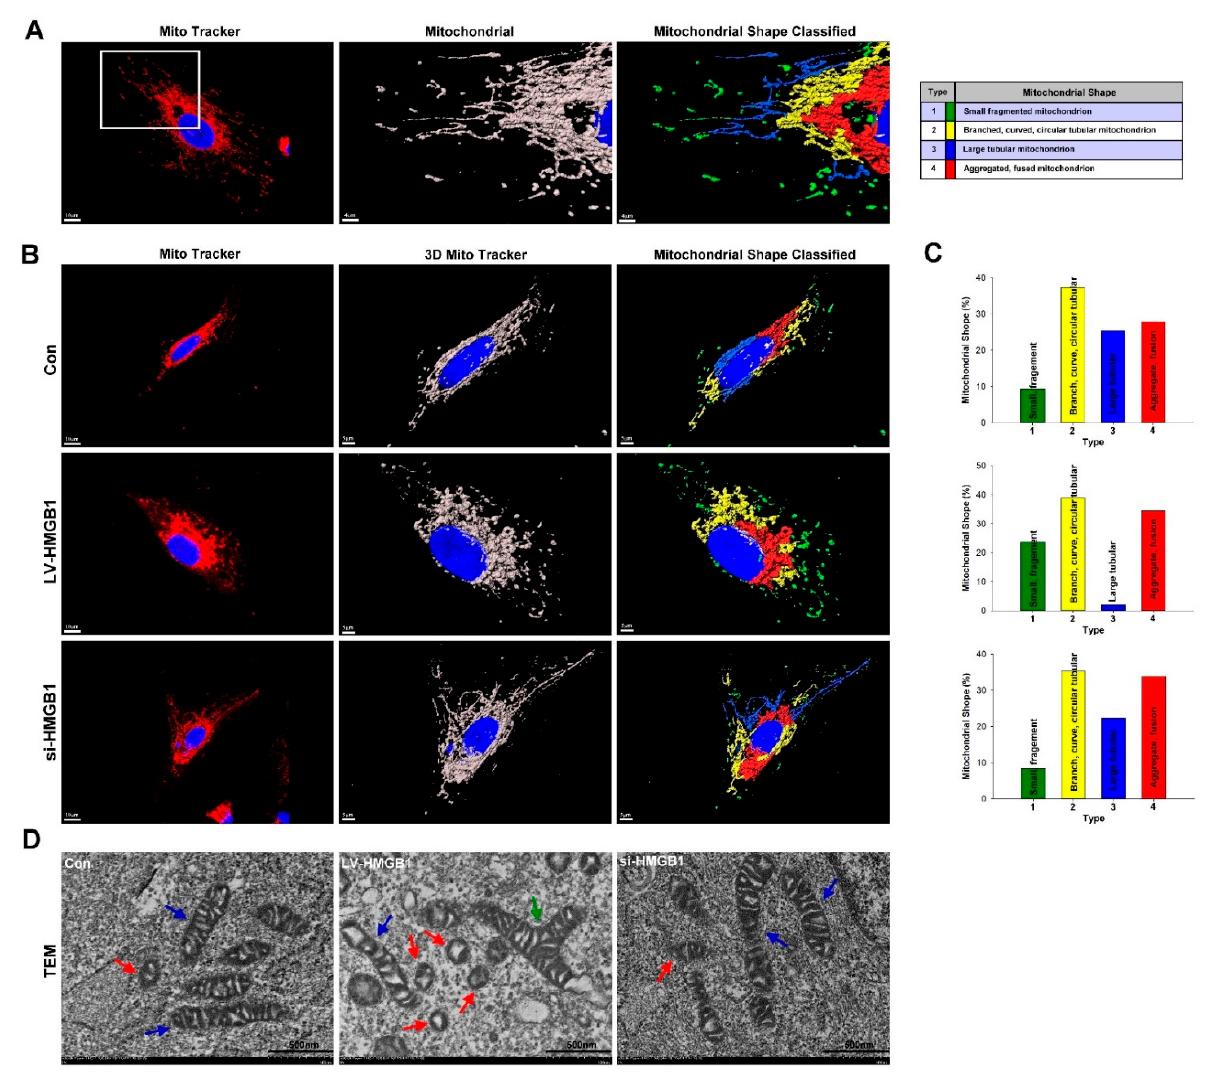
Figure 2. Mitochondrial dynamics is regulated by HMGB1. ( A ) Mitochondria were stained using the mitochondria tracker dye (red color) and nucleus dye (blue color) and analyzed using confocal microscopy and the Imaris software. Mitochondrial shapes (highlighted in white square as an example) were classified as type 1 (small fragmented mitochondria), type 2 (branched, curve, circular, and tubular mitochondria), type 3 (large tubular mitochondria), and type 4 (aggregated and fusion mitochondria). ( B , C ) A549 cells were transfected with LV-HMGB1 or si-HMGB1, respectively, for 48 h. The types of mitochondrial shapes were classified and quantified using confocal microscopy, the Imaris software, and the Mountains 8 software. ( D ) TEM analysis was used to confirm mitochondrial shapes (blue arrows: large mitochondria; red arrows: small fragmented mitochondria; green arrows: branched mitochondria).